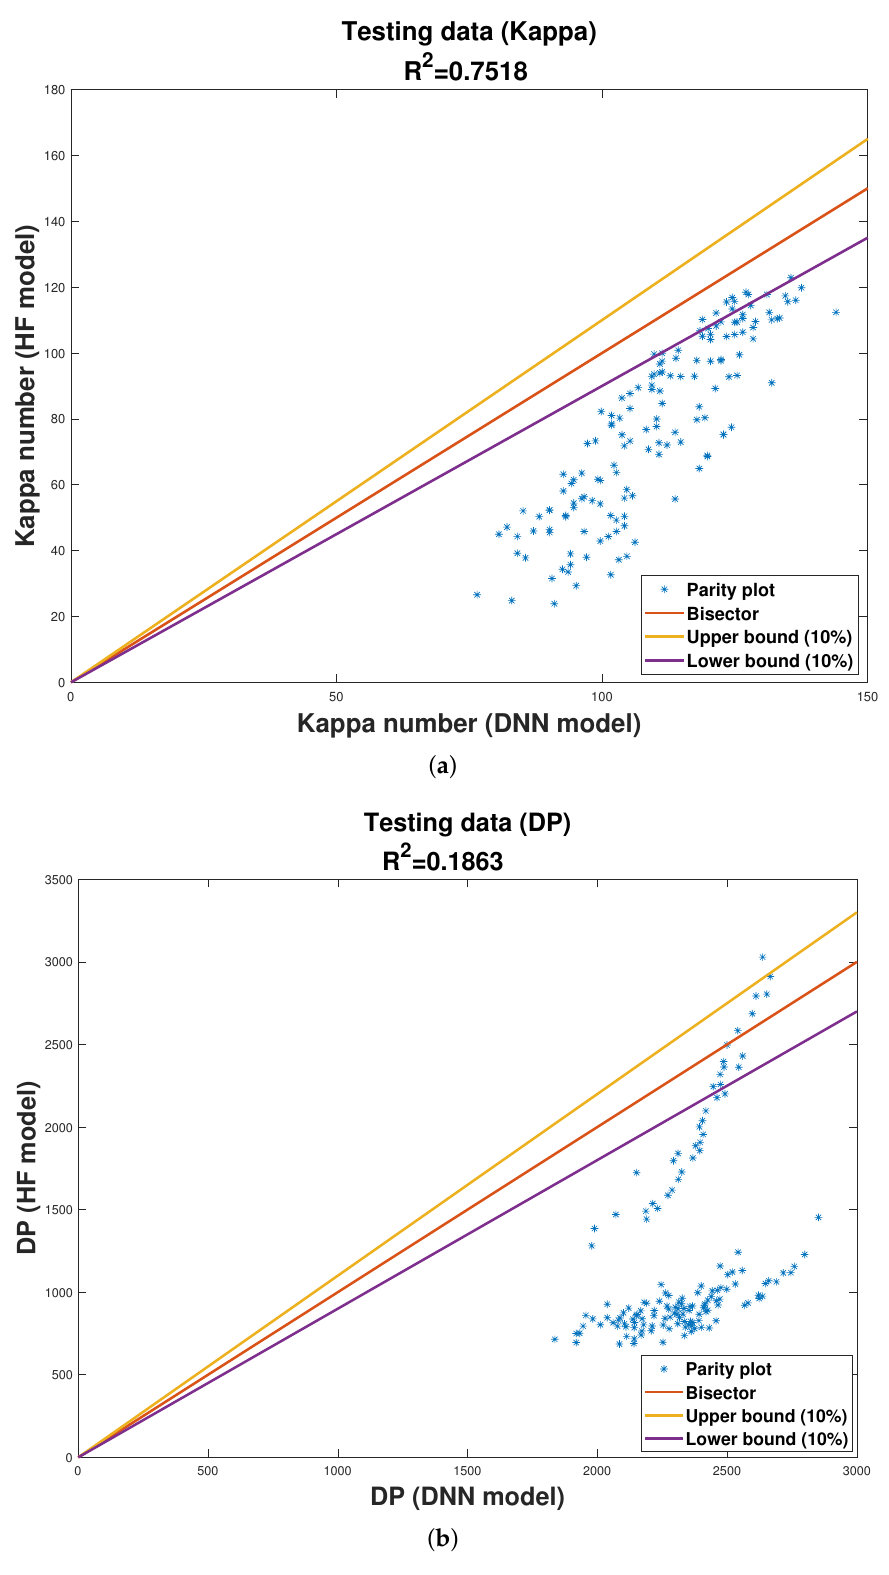
Figure 7. ( a ) Parity plot for the Kappa number prediction for the test data (100 datasets) at t = t end with the DNN model and ( b ) parity plot for DP prediction for the test data (100 datasets) at t = t end with the DNN